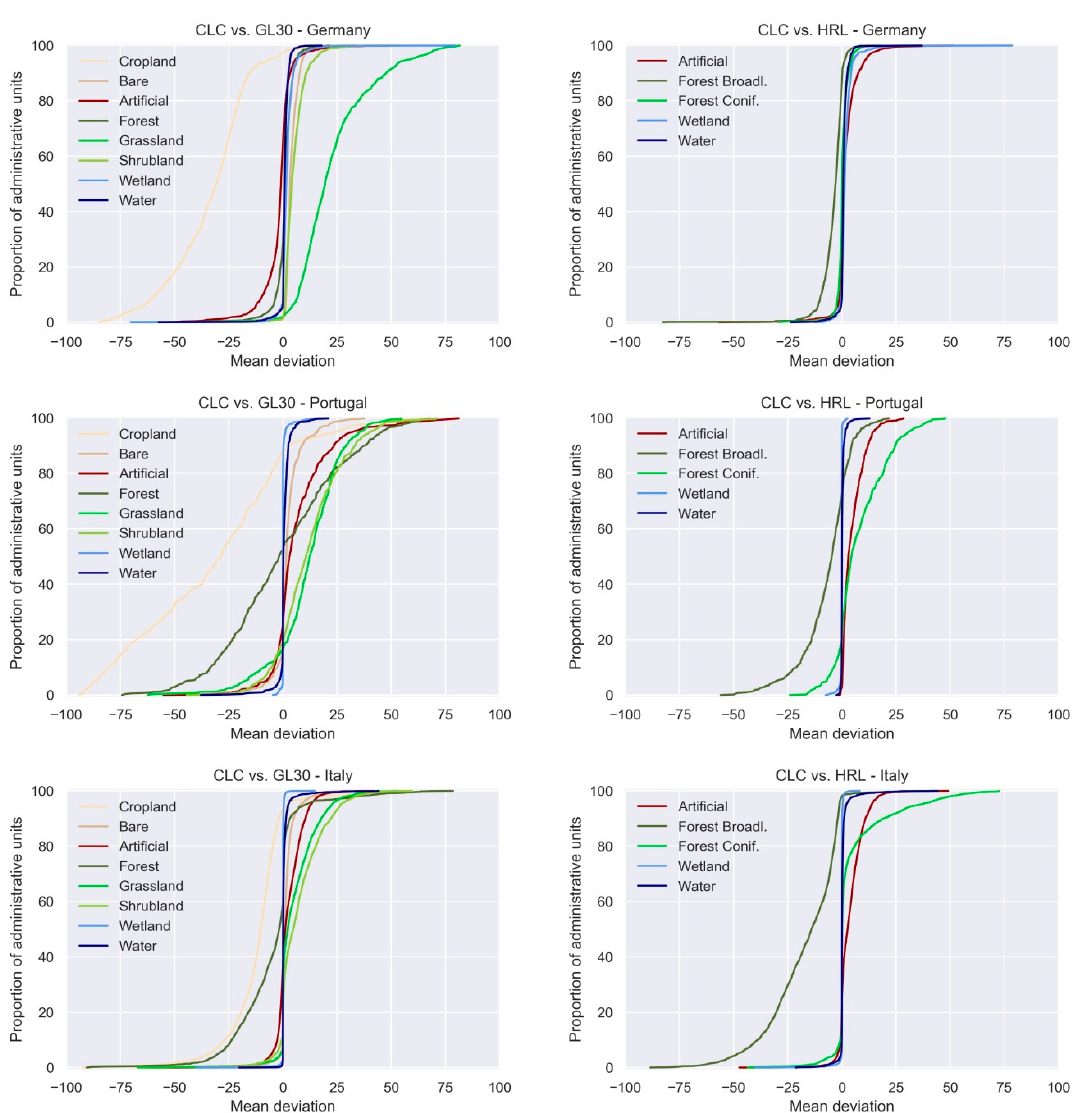
Figure 5. Share of administrative units for the three study regions with a specific difference in percentage points between the present classification and Globeland30 (GL30) and High Resolution Layers (HRLs) for the respective classes.